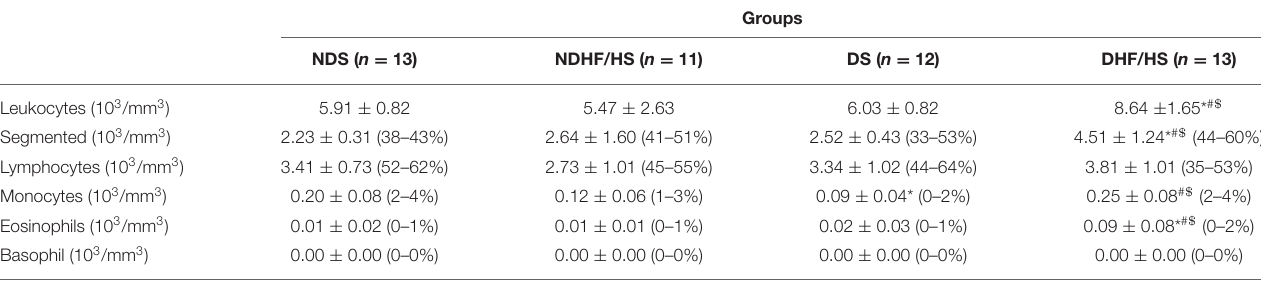
TABLE 4 | A hematological profile at term pregnancy of non-diabetic (ND) and diabetic (D) rats treated or not (S) with high-fat/high-sugar diet (HF/HS) before and during pregnancy.